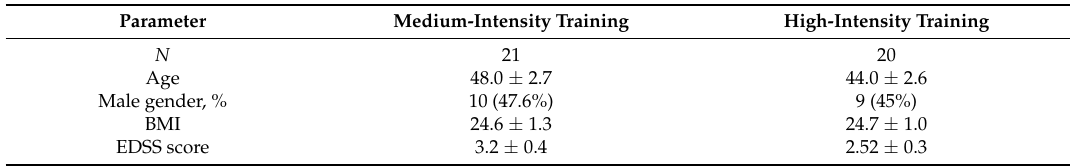
Table 2. Pre and post training descriptive statistics and lipoprotein profile measurements in the multiple sclerosis (MS) study